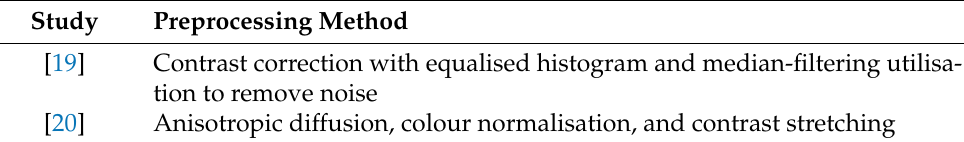
Table 1. Preprocessors utilised in segmentation process of